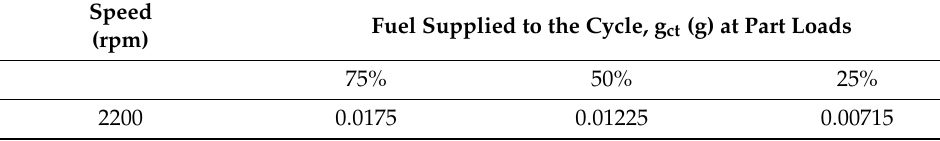
Table 3. Injected fuel mass at part